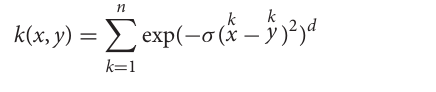
TABLE 4 | The parameters setting of the SVM with the ANOVA